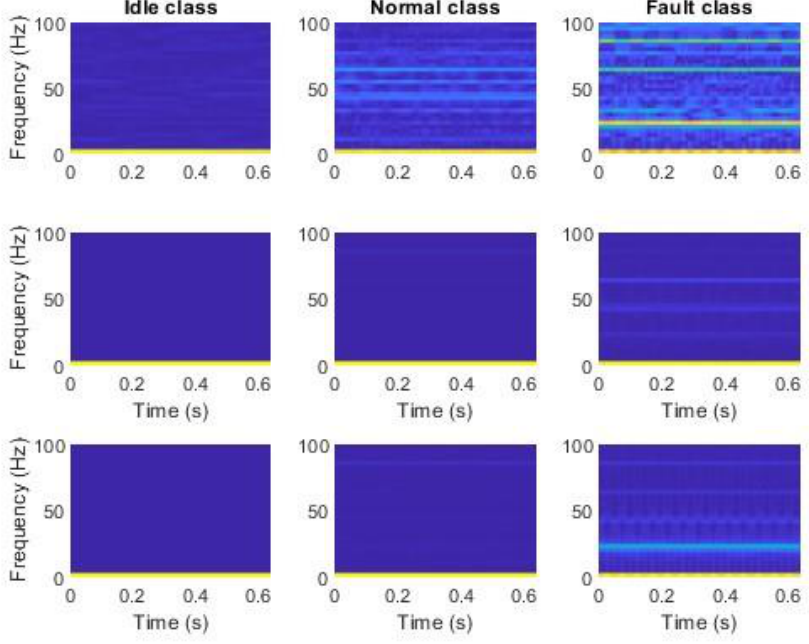
Figure 13. Accelerometer data in the time–frequency domain using mSDFT in the 3-axis: top row, Z , middle row, Y , bottom row— X .